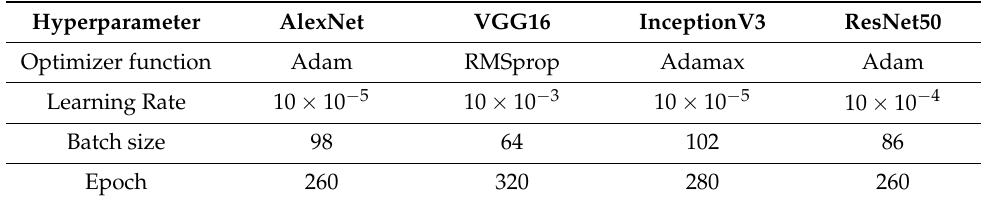
Table 1. Results of the hyperparameter optimisation.